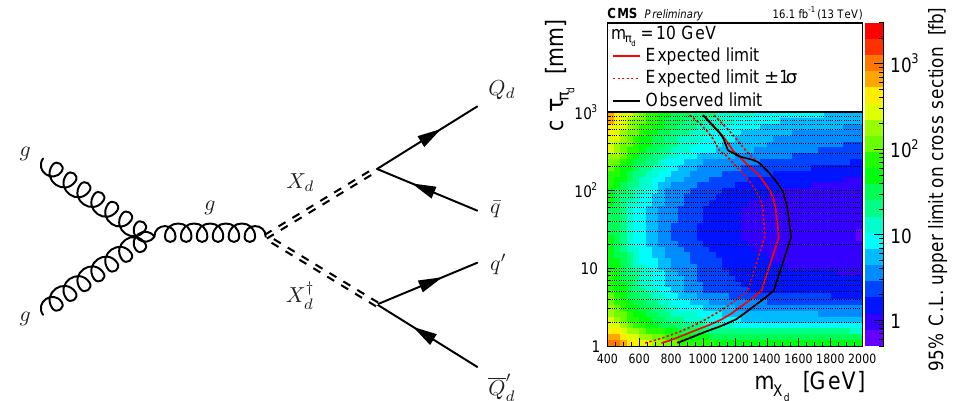
Figure 12. Feynman diagrams for pair production of mediator particles, with mediator decay to a quark and a dark quark in the BSSW model [48,49] via gluon fusion ( left ). Signal exclusion curves derived from theory-predicted cross sections and upper limits at 95% CL on the signal cross-section for models with dark pion mass of 10 GeV ( right )